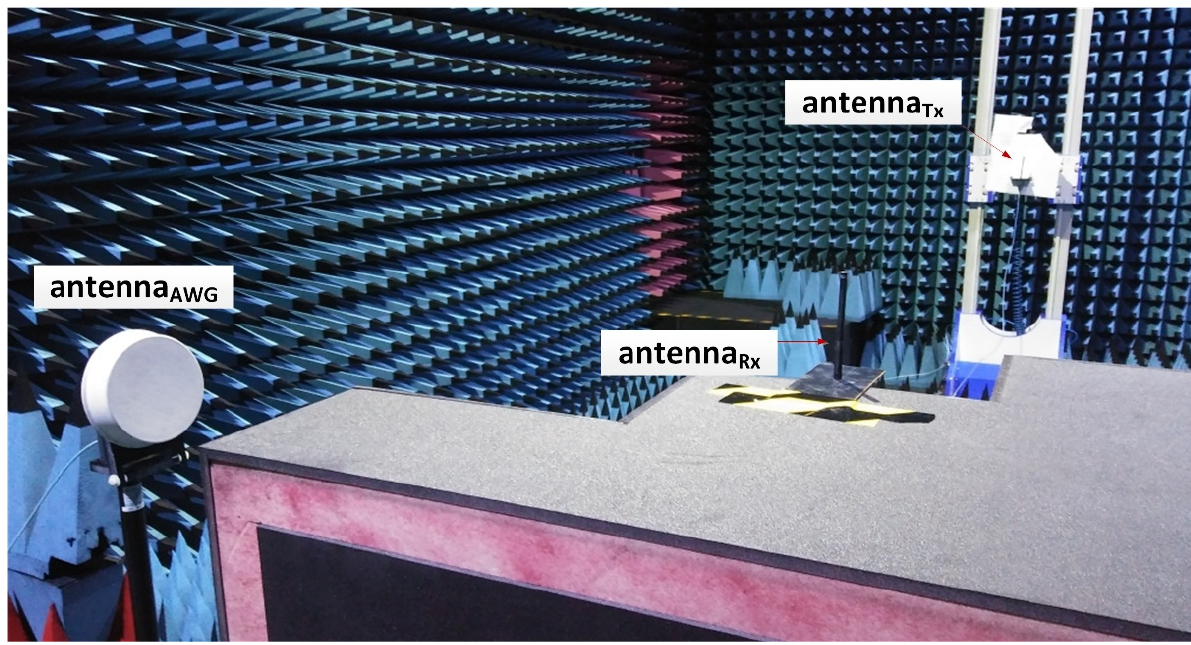
Figure 5. A schematic of the set-up used for measuring the Wireless M-Bus system in the LEC (WUST) anechoic chamber.